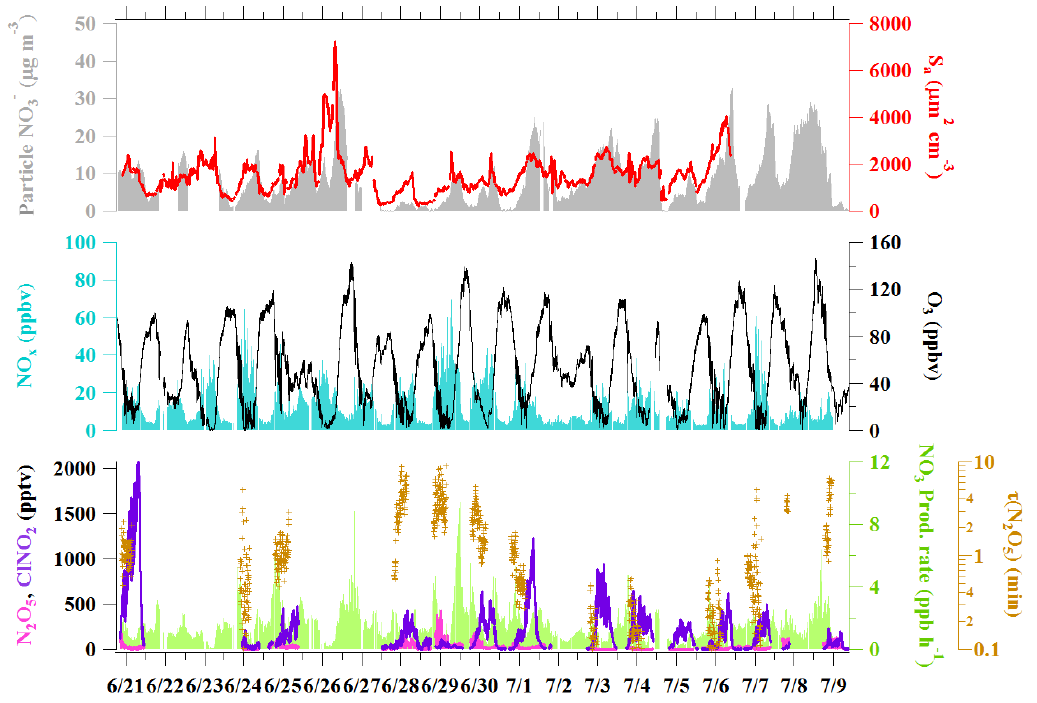
Figure 1. Time series of concentrations of N 2 O 5 , ClNO 2 , NO 3 production rates, the steady-state lifetimes of N 2 O 5 , and related gas and aerosol data at Wangdu from 21 June to 9 July 2014. N 2 O 5 and ClNO 2 are 1min averaged data, whereas the NO x , O 3 , and NO 3 production rates and τ (N 2 O 5 ) are given as 5min averages. The data for S a and fine particulate NO − The data gaps were caused by technical problems, calibrations, or instrument maintenance.